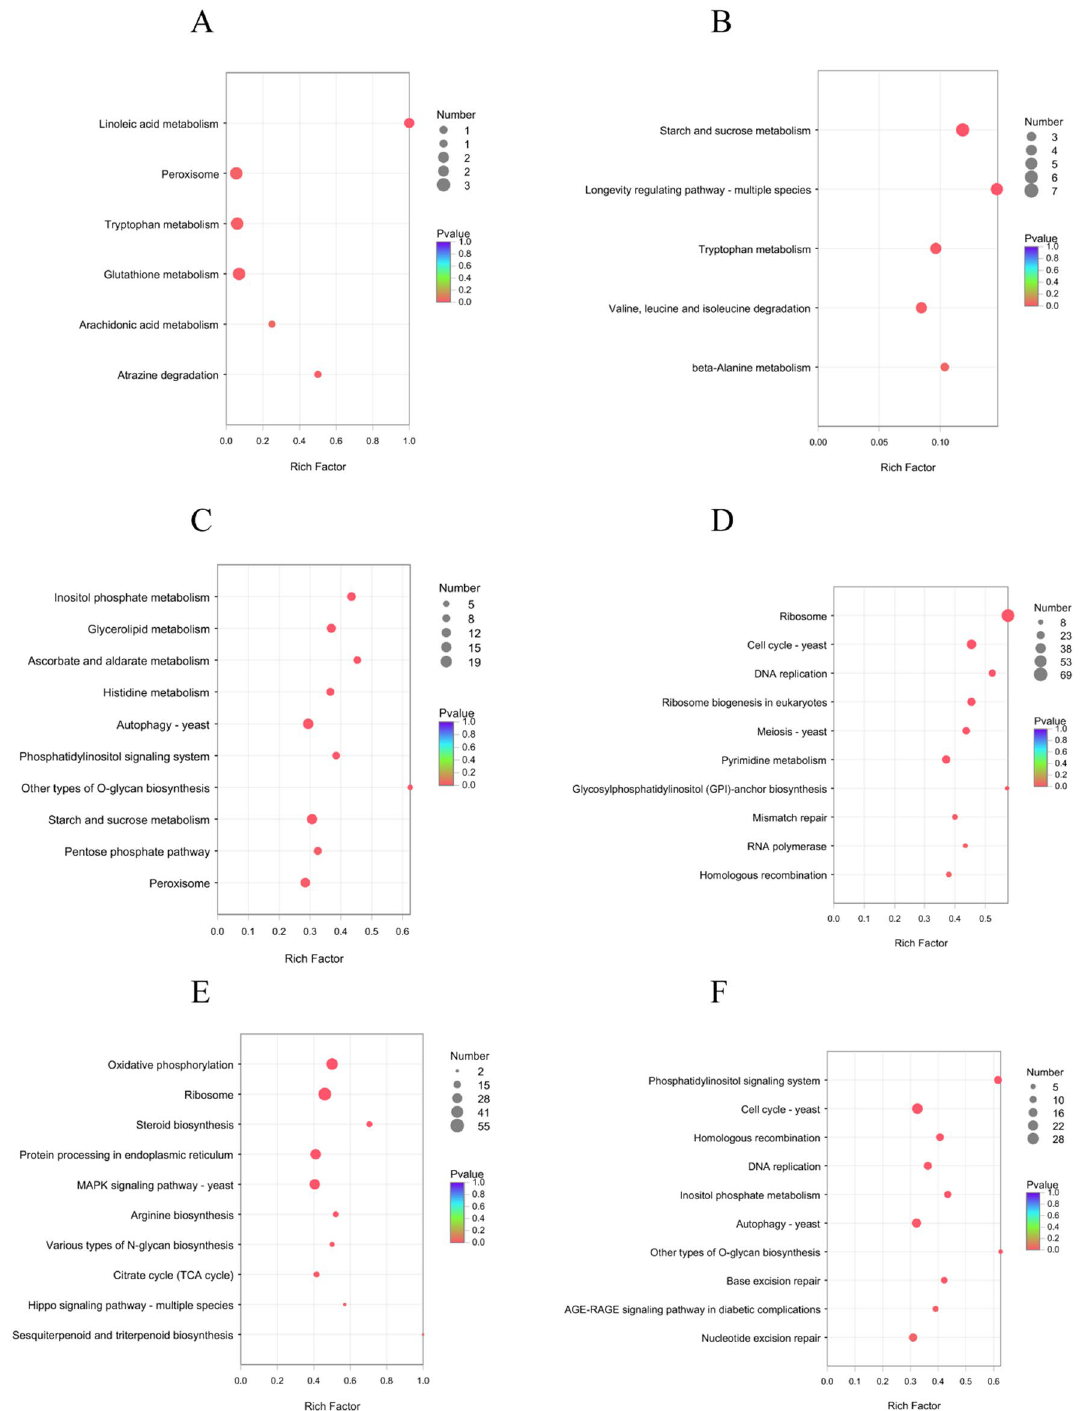
Figure 7. KEGG pathway enrichment analyses of the four stages of fruiting body development in C. comatus . ( A ) Up-regulated unigenes between stages M and I; ( B ) down-regulated unigenes between stages M and I; ( C ) up-regulated unigenes between stages D and M; ( D ) down-regulated unigenes between stages D and M; ( E ) up-regulated unigenes between stages A and D; ( F ) down-regulated unigenes between stages A and